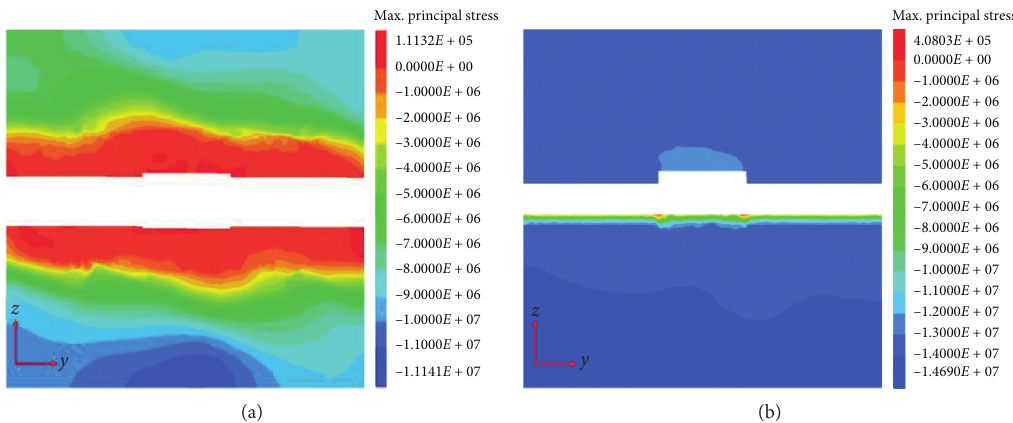
Figure 9: Maximum principal stress (slice plane 1). (a) Without support. (b) Prestressed anchor cable support.